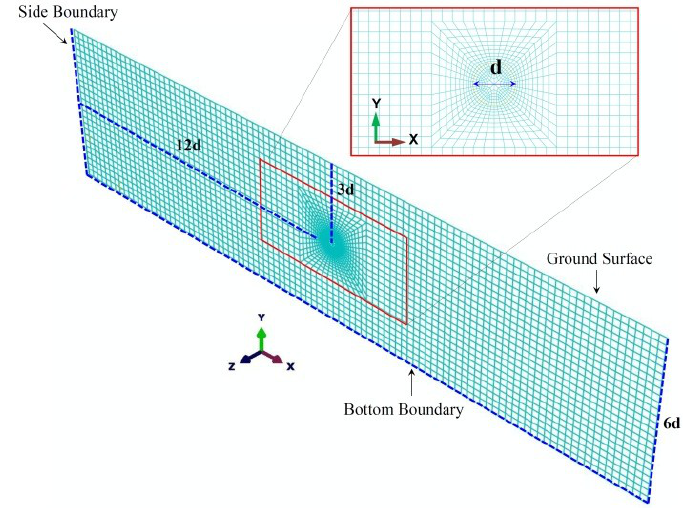
Figure 2. The geometry of the surrounding rock and the excavation section. Table 1. Mechanical properties of the lining [15,16].